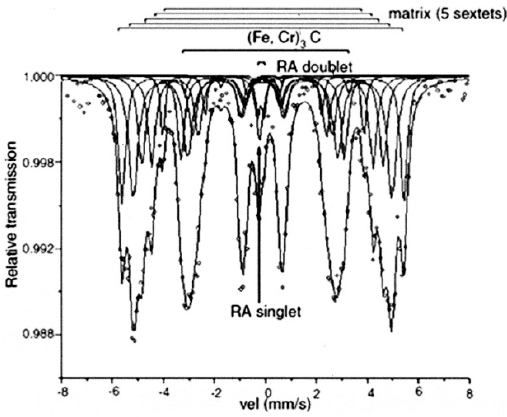
Figure 11. Mössbauer transmission spectrum of a 9Cr–1Mo steel foil slowly cooled from the austenitization temperature. Reproduced from [32], with permission from Authors, 1976.